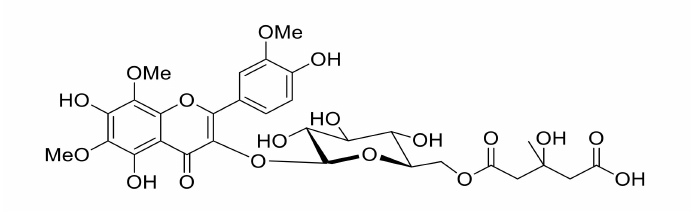
Figure 2. Chemical structure of yellow #15: limocitrol 3- O -6”-(3-hydroxy-3-methylglutaryl)- β - d